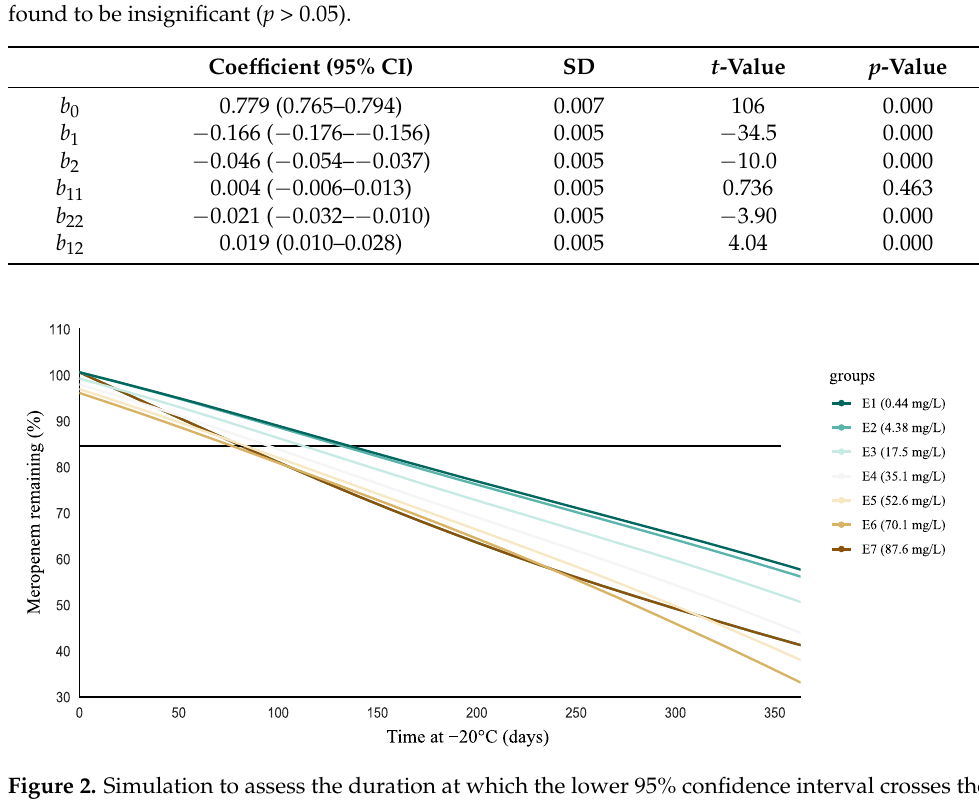
Figure 2. Simulation to assess the duration at which the lower 95% confidence interval crosses the critical threshold of 85% degradation (horizontal black line). Critical threshold values are shown in Table S1 (Supplementary Materials). It can be observed that significant degradation occurred relatively more rapidly with increasing concentrations. This effect appeared to stabilize at higher concentrations, resulting in the degradation becoming significant at around 80 days for concentrations above 35.1